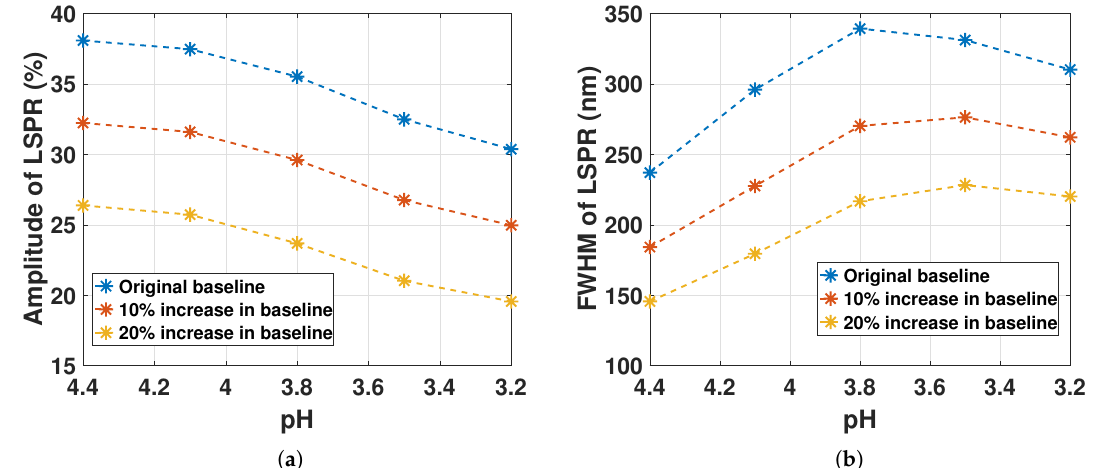
Figure 14. ( a ) Amplitude from the reflectance of GNP-hydrogel with ND 03 at 1.7 × 10 11 particles/mL for decreasing pH with an increasing baseline; ( b ) FWHM from the reflectance of GNP-hydrogel with ND 03 at 1.7 × 10 11 particles/mL for decreasing pH with an increasing